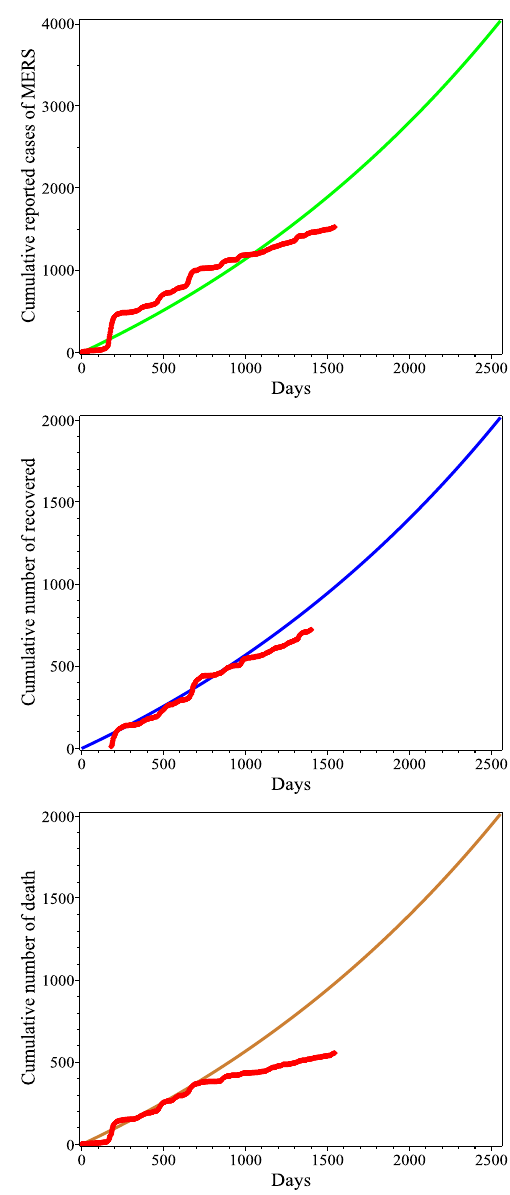
Fig. 4: Saudi simulations with R c = 1 . 004 . Cumulative cases of MERS (T), cumulative number of recovered (M), and cumulative number of death (B). The red dots are the field data. The run was for 2555 days ( ∼ 84